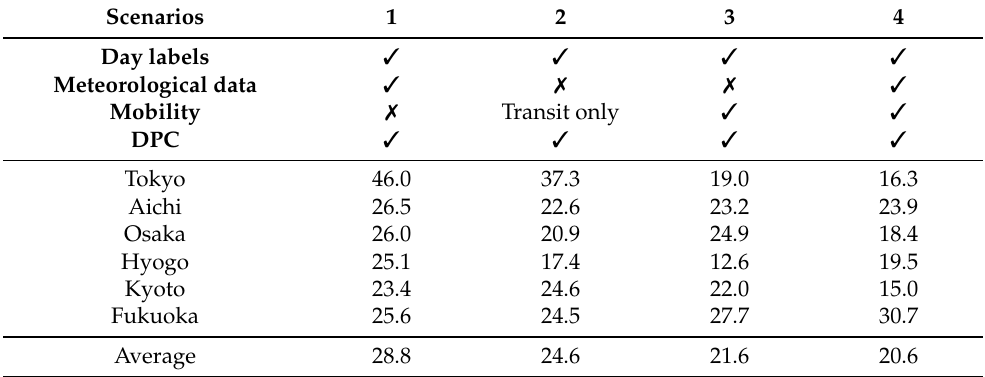
Table 2. Average absolute error [%] computed using different scenarios for data blend for all study